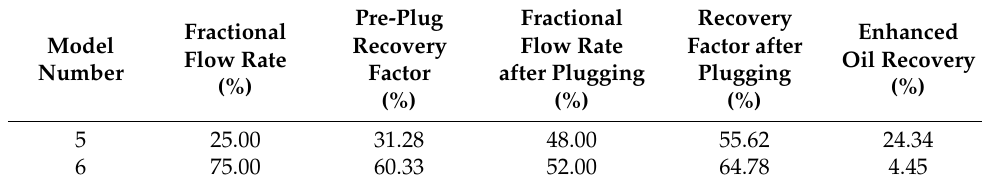
Table 4. Experimental data of the oil